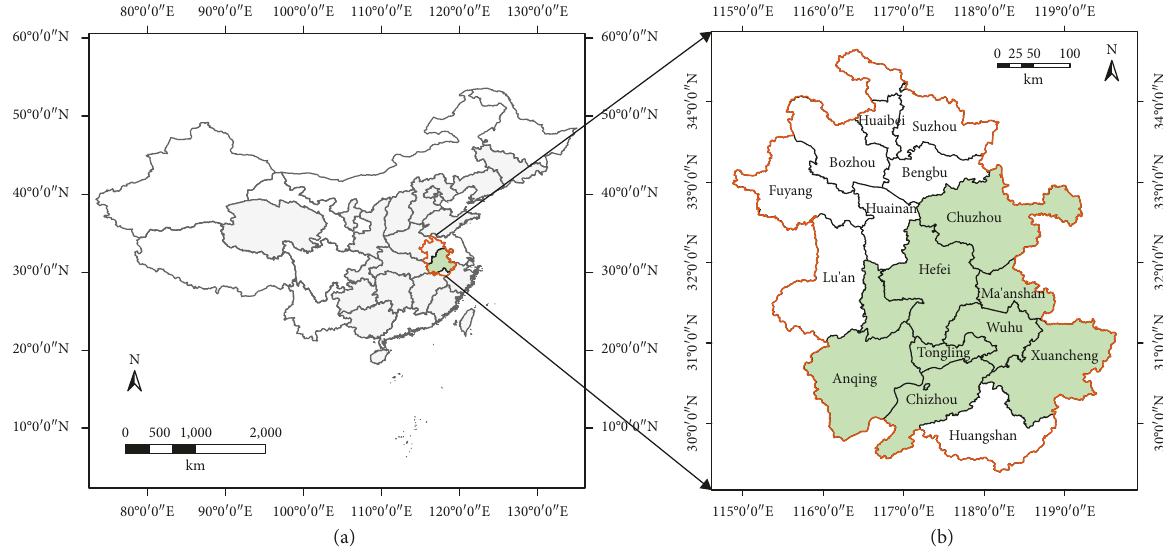
Figure 1: The location of (a) Anhui Province and (b) Wanjiang City Belt